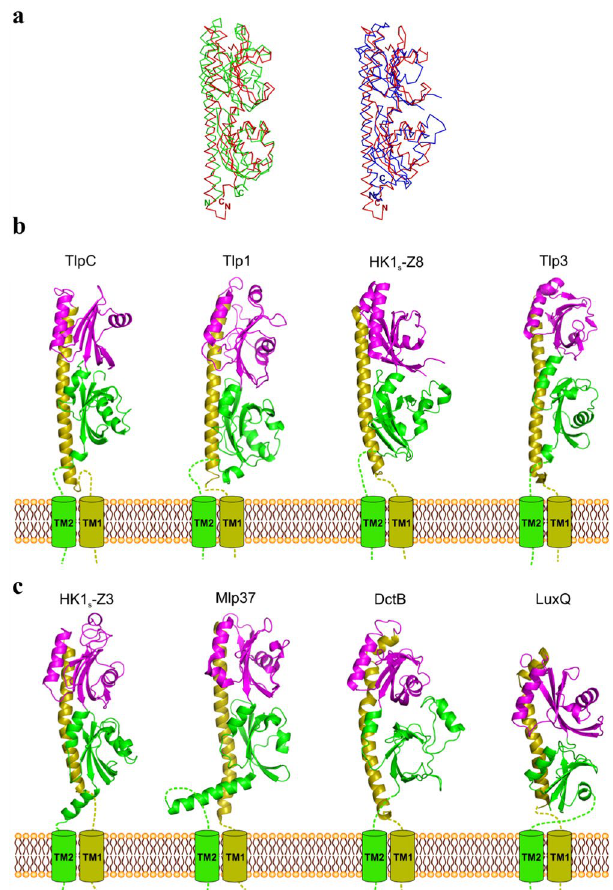
Figure 2. Comparison of dCACHE LBD of TlpC with structures of other dCACHE domains. ( a , b ) Structural superposition of TlpC LBD (C α trace, in red) with dCACHE domains of ( a ) Tlp1 (C α , in green, PDB entry 4wy9 24 ) and ( b ) HK1s-Z8 (C α , in blue, PDB entry 3lie 43 ). ( c ) LBDs of TlpC, Tlp1 (PDB entry 4wy9 24 ), HK1s-Z8 (PDB entry 3lie 43 ), Tlp3 (PDB entry 4xmq 23 ), HK1s-Z3 (PDB entry 3lib 43 ), Mlp37 (PDB entry 5ave 51 ), DctB (PDB entry 3by9 52 ) and LuxQ (PDB entry 1zhh 53